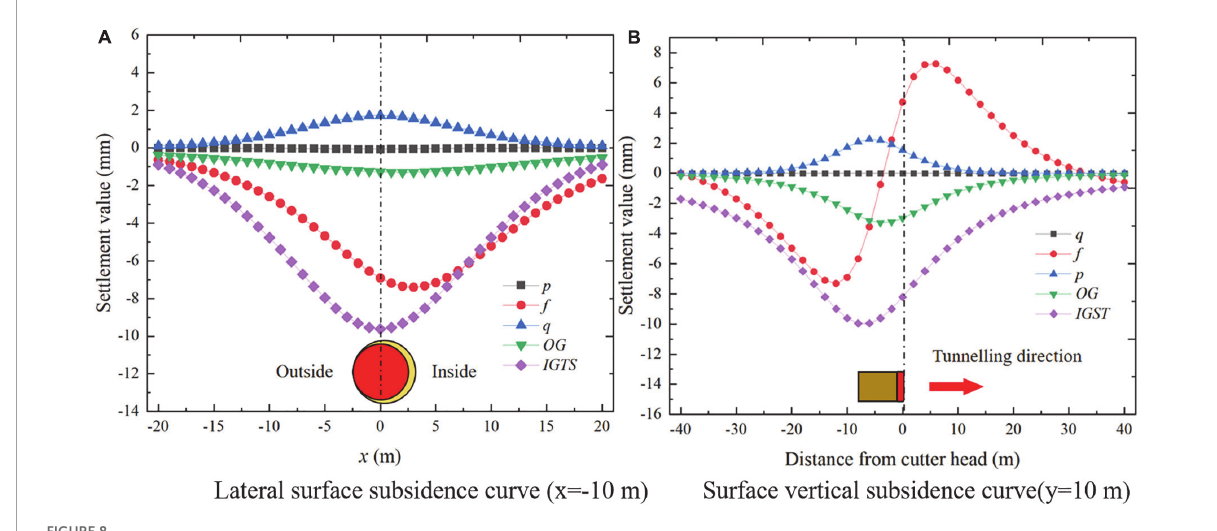
FIGURE8 Surface settlement curve caused by construction factors. (A) Lateral surface subsidence curve ( x = − 10 m) and (B) surface vertical subsidence curve ( y = 10 m).